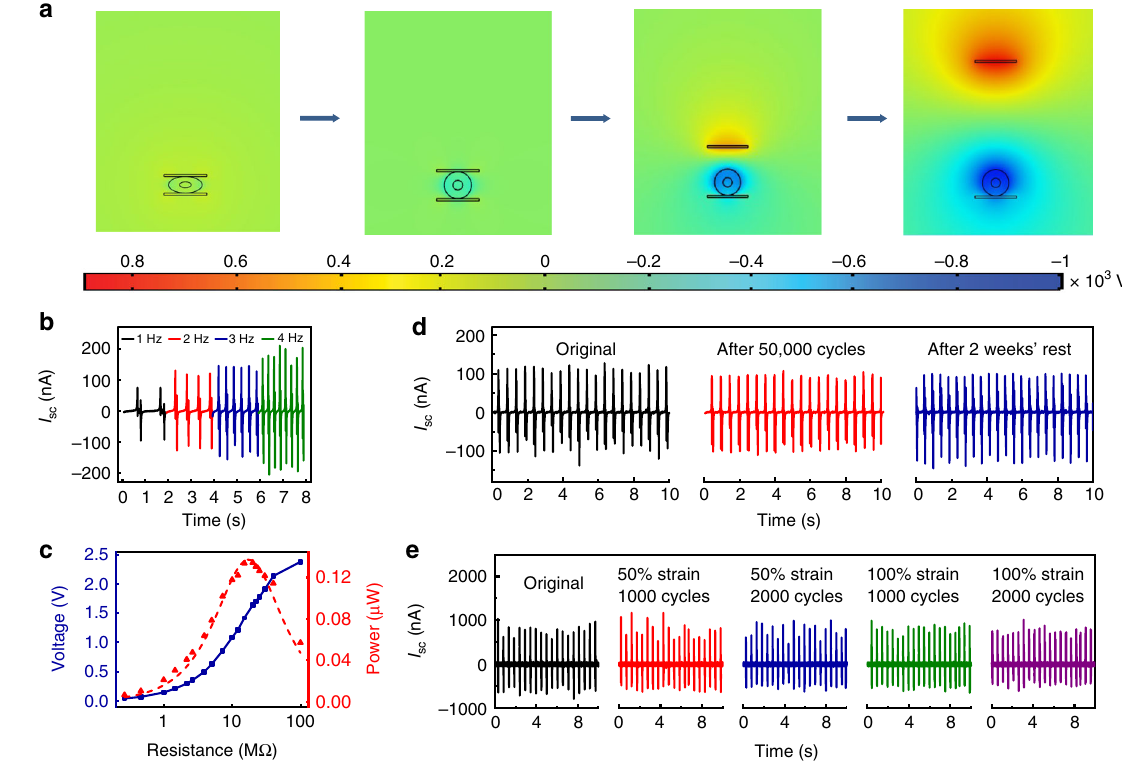
Fig. 2 Electrical output performance of triboelectric fi bers. a Finite element simulation of the potential distribution of a fi ber with a single liquid metal electrode under open-circuit condition. b Variation of I sc with frequency of stimulation (contact length: 3 cm). c Dependence of the output voltage and peak instantaneous power on the loaded resistors. d Long-term output stability tests under continuous pressing for 50,000 cycles, together with the outputs after being stored in ambient atmosphere for 2 weeks (contact length: 3 cm). e Variation of I sc after repeated stretching cycles at 50 and 100% strain for 2,000 cycles, respectively. A longer fi ber with the contact length of 10 cm and a slightly larger pressure were